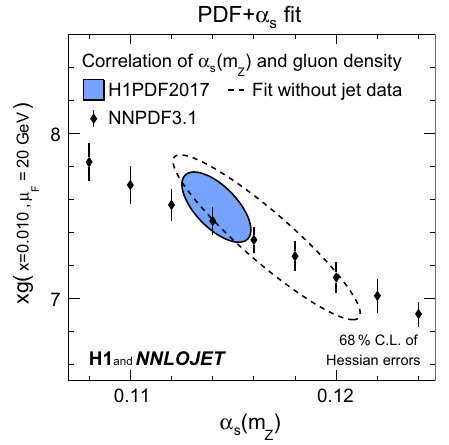
Fig. 17 ErrorellipsesofHessianuncertaintiesat68%confidencelevel of α s ( m Z ) and the gluon density xg at μ F = 20GeV and x = 0 . 01 as a result of two different PDF+ α s -fits. The filled ellipse indicates the result of the H1PDF2017 [NNLO] fit and the dashed line of a PDF+ α s -fit with jet data excluded. The error ellipses represent the combined effect of experimental and hadronisation uncertainties as described in the text. The diamonds indicate the gluon density of the NNPDF3.1 PDF set for fixed values α PDF s ( m Z